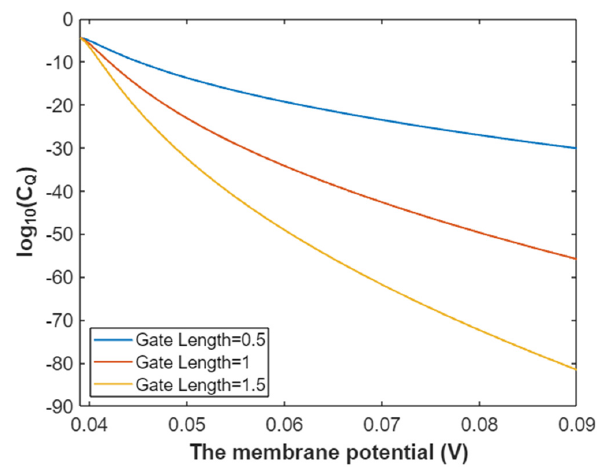
Figure 26. The relationship between membrane potential and the common logarithm of quantum conductance of a single potassium channel for intracellular potassium ions at G = 5.35 and over a membrane potential range from 0.039 V to 0.09 V.